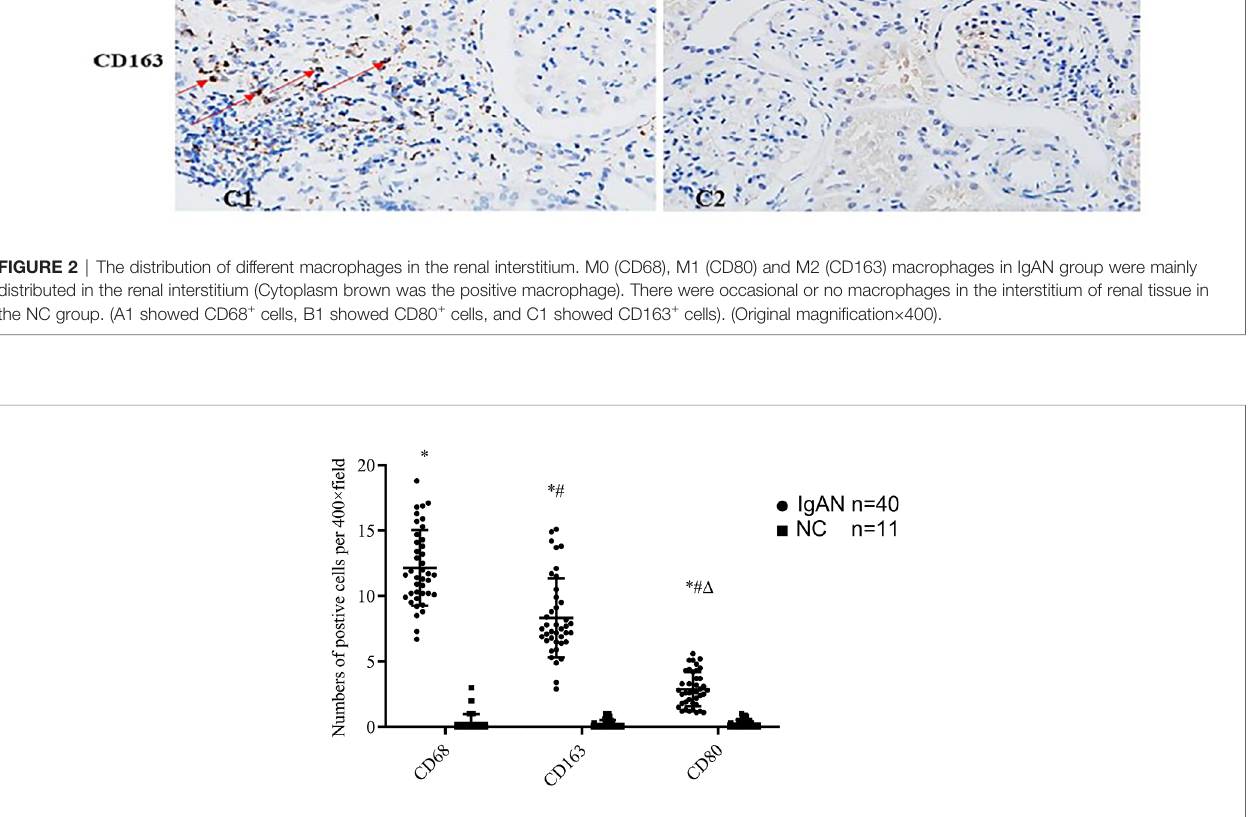
FIGURE 3 | The expressions of different macrophages. The positive expressions of M0 (CD68), M1 (CD80) and M2 (CD163) in renal macrophages showed statistically signi fi cant differences between IgAN and NC. *P<0.0001, IgAN vs . NC; #P < 0.0001, CD163/CD80 vs . CD68; △ P < 0.0001, CD163 vs . CD68. The positive expression of CD163 was higher than that of CD80, and the polarization of M0 towards M2 was